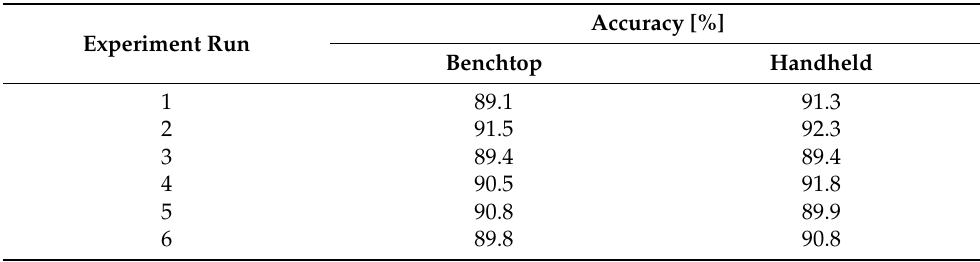
Table A6. Result of testing three cheese categories (Alpine-style cheeses identified as “Gruy è re” manufactured from unpasteurized milk, other Alpine-style cheese produced from unpasteurized milk, Wisconsin Alpine-style cheese produced from pasteurized milk). The table reports 10 independent 5 × 2 cross-validation